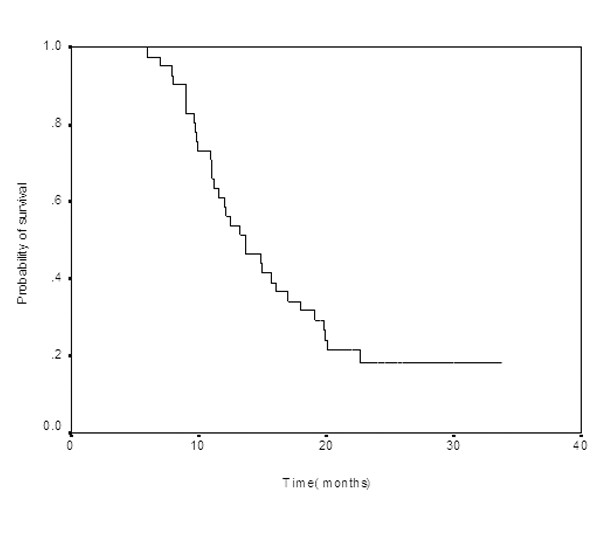
Overall survival for all patients.